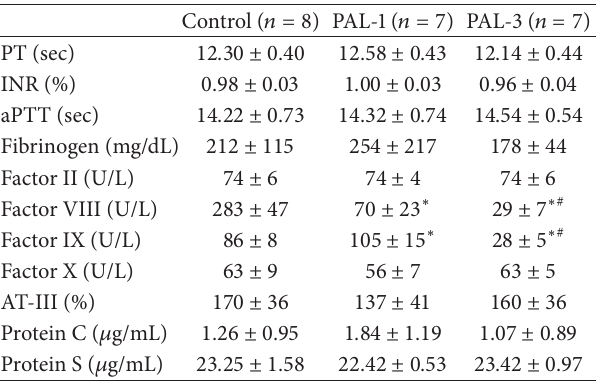
Table 2: Hemostatic parameters in control, PAL-1, and PAL-3